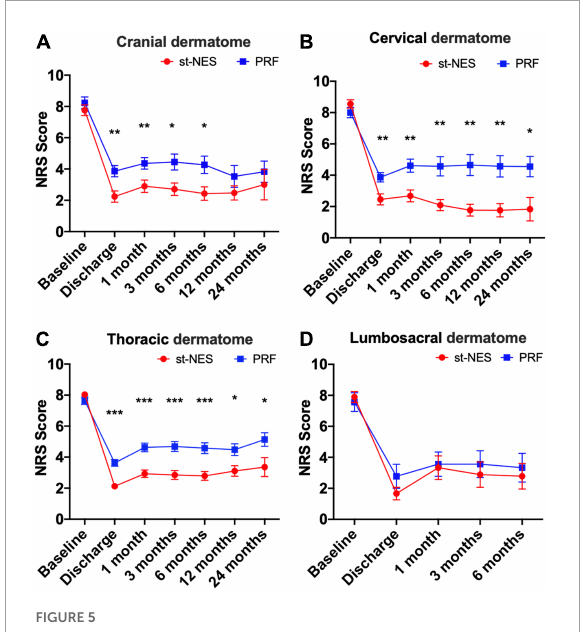
FIGURE5 (A–D) Comparison of two groups treatment modalities at different sites [ n = 226, * P < 0.05, ** P < 0.01, *** P < 0.001, indicate pulsed radiofrequency (PRF) group vs. short-term nerve electrical stimulation (st-NES) group, P -values for group comparisons by Mann–Whitney U -test].